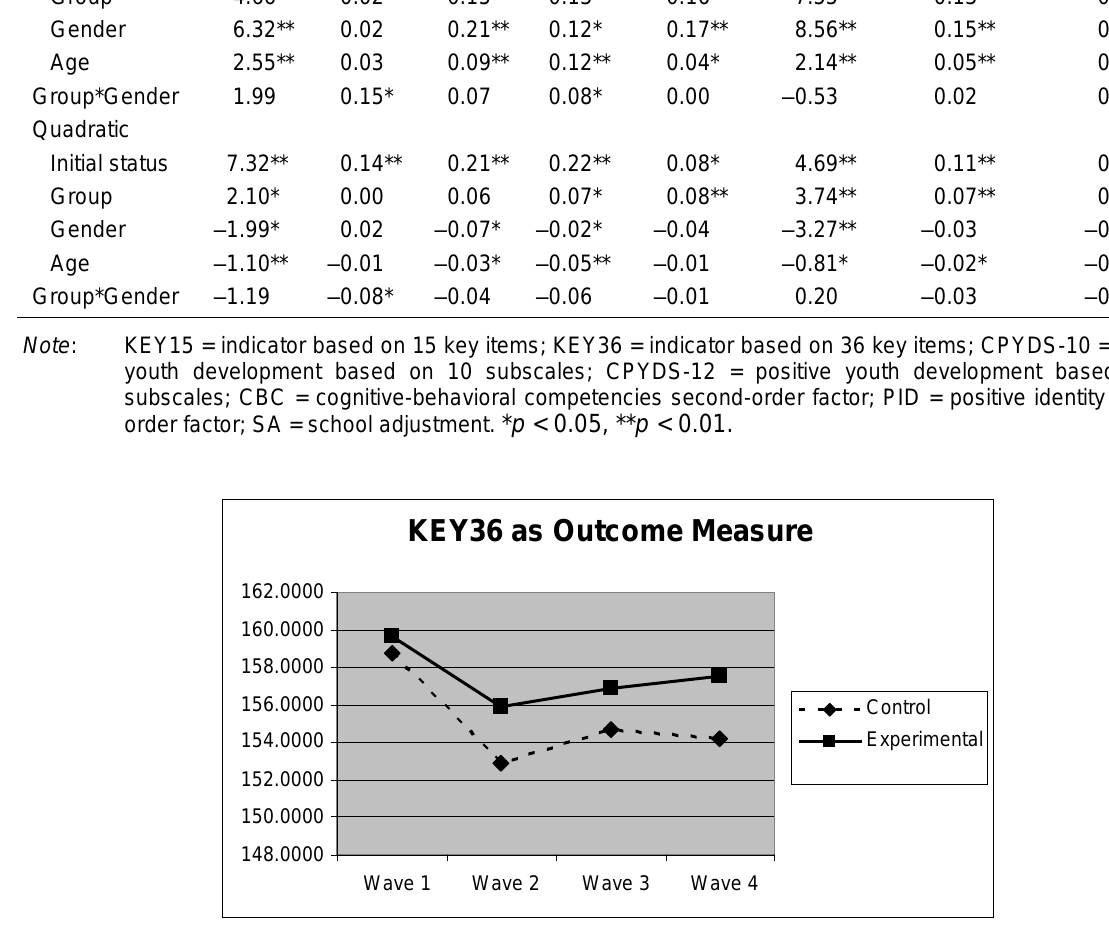
FIGURE 1. Growth trajectories in the experimental participants participating in the Tier 1 Program and control participants using KEY36 as an outcome